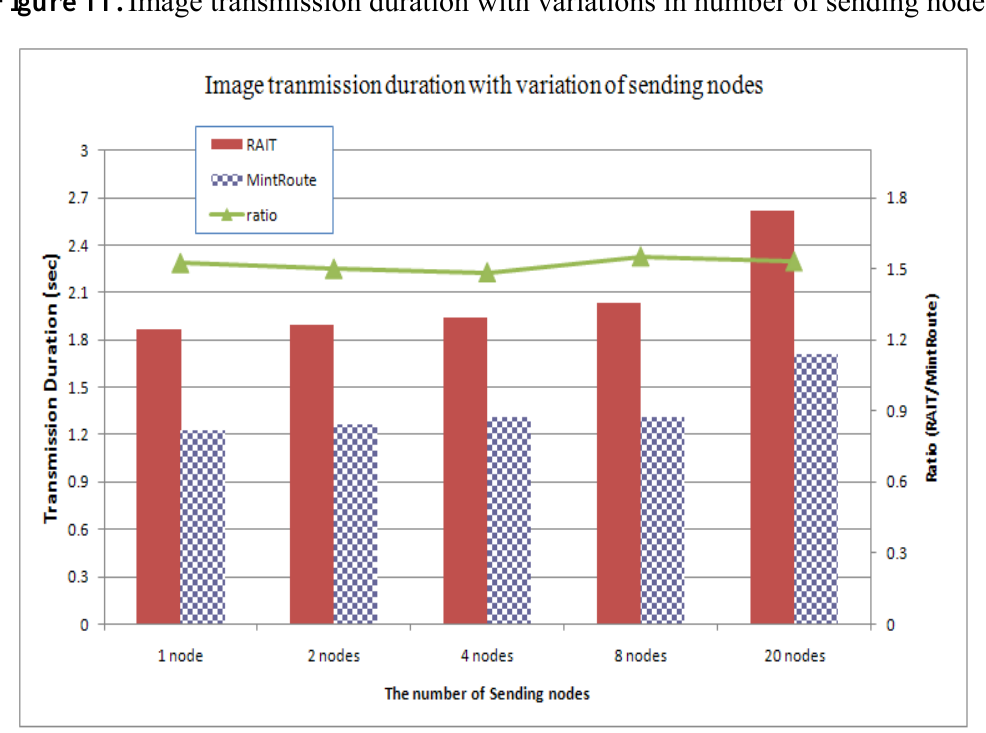
Figure 11. Image transmission duration with variations in number of sending